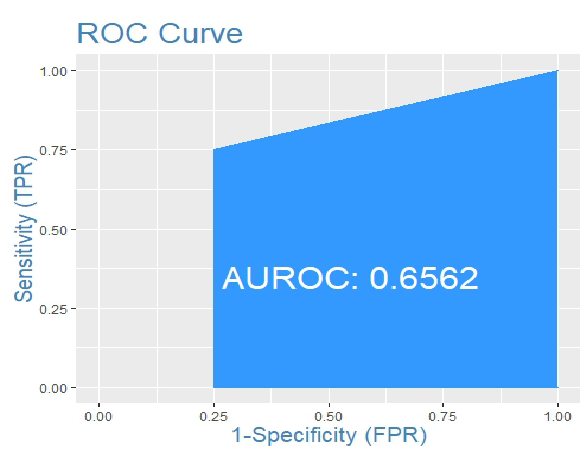
Table 6. Evaluation measures obtained for SVM